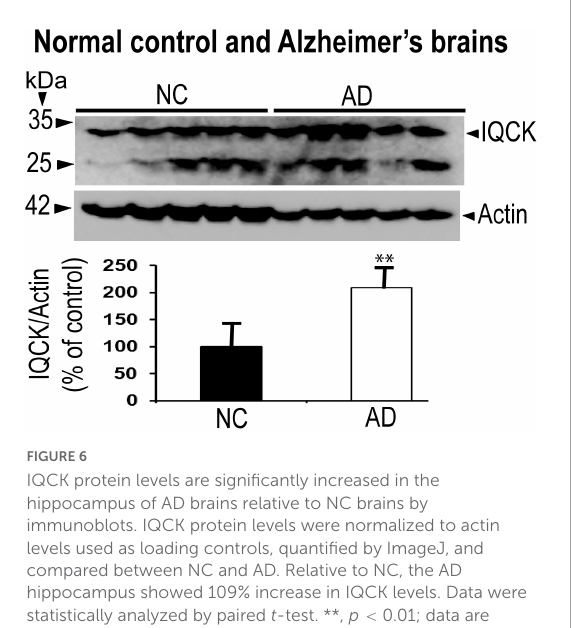
TABLE 1 Demographics of normal control and Alzheimer’s disease patients.